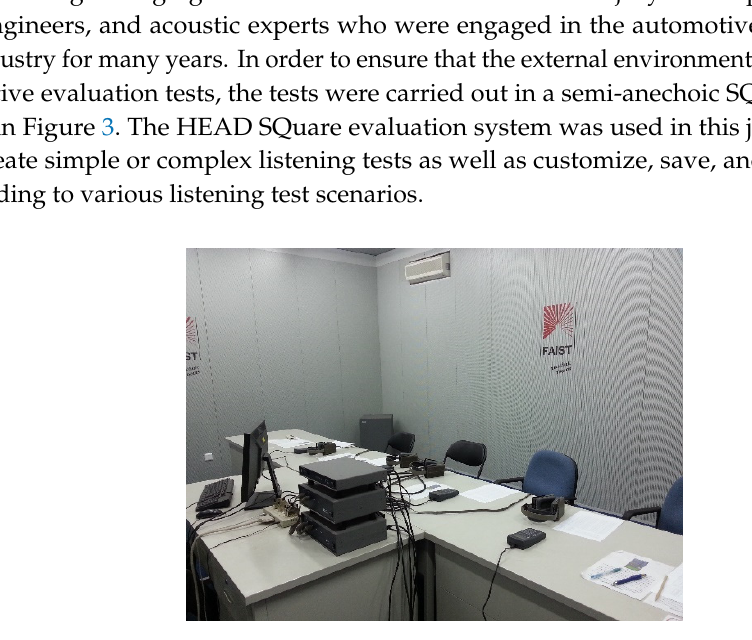
Figure 3. Subjective sound quality (SQ) evaluation anechoic chamber.